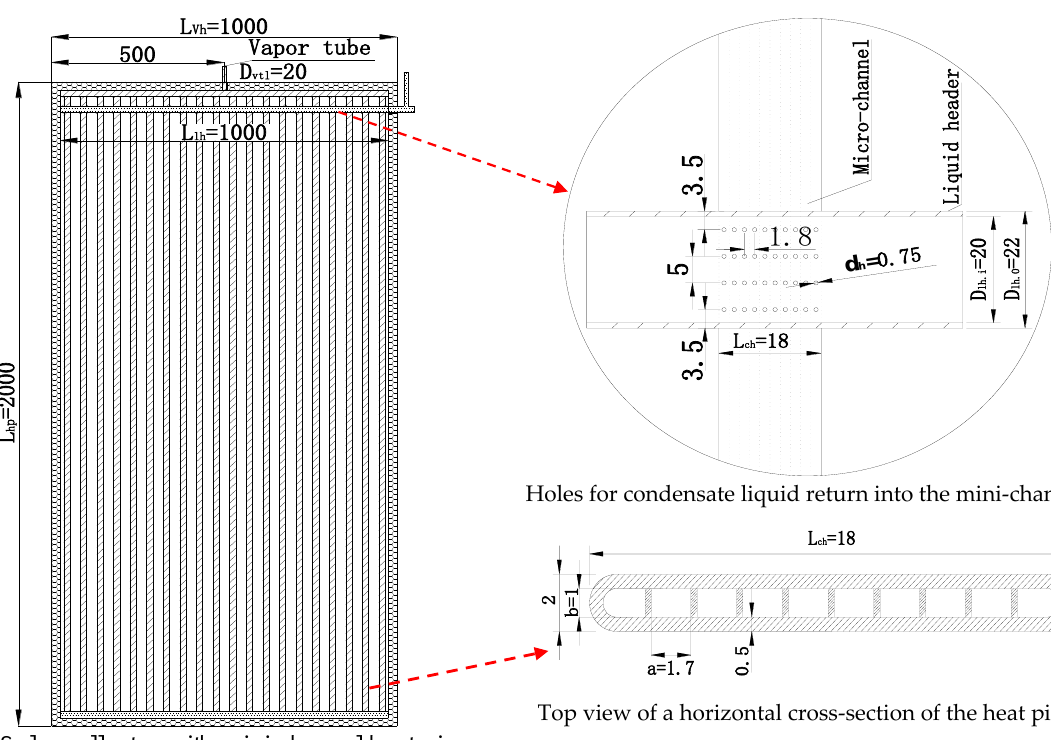
Figure 2. Solar collector with mini-channel heat pipes and condensate liquid pathway (units in mm).